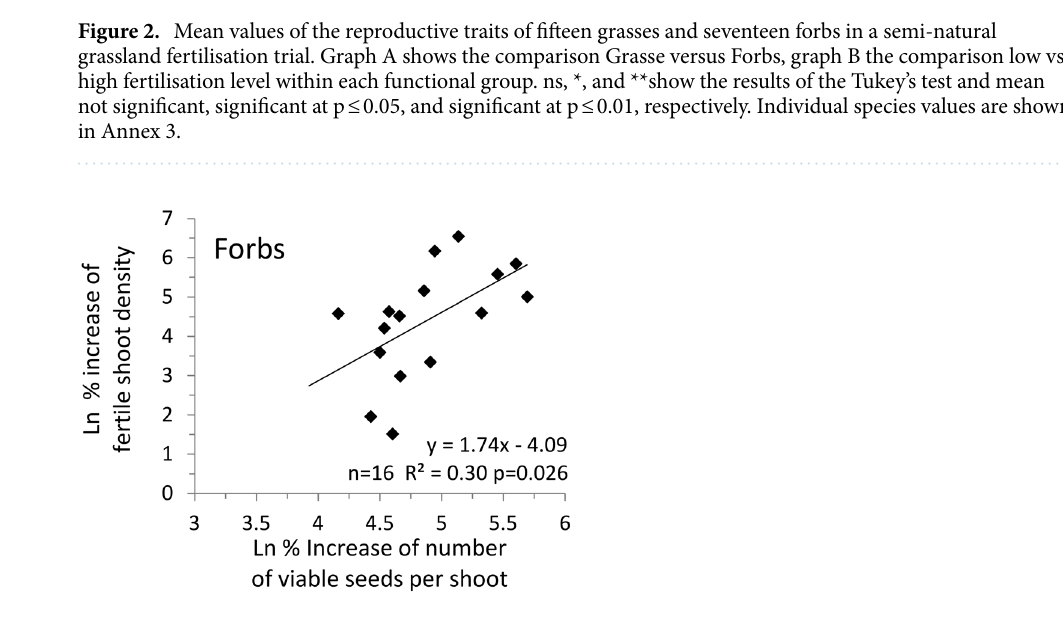
Figure 3. Relation between variation of number of viable seeds pr shoot at higher compared to lower fertilisation level and variation of fertile shoot density in seventeen grassland forbs. Data from a fertilisation trial in a semi-natural grassland of the Italian eastern